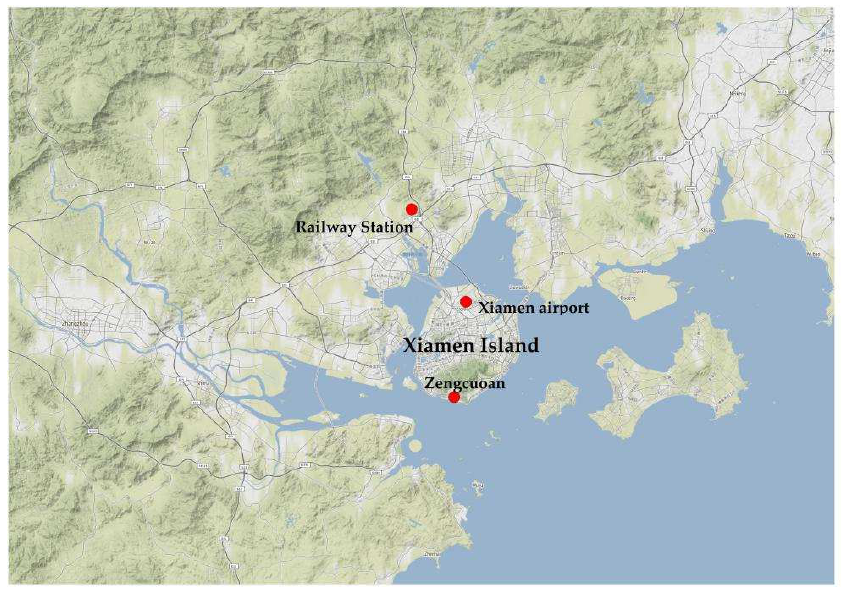
Figure 2. Location of Xiamen City. Source: Adapted by the authors from Stamen map.